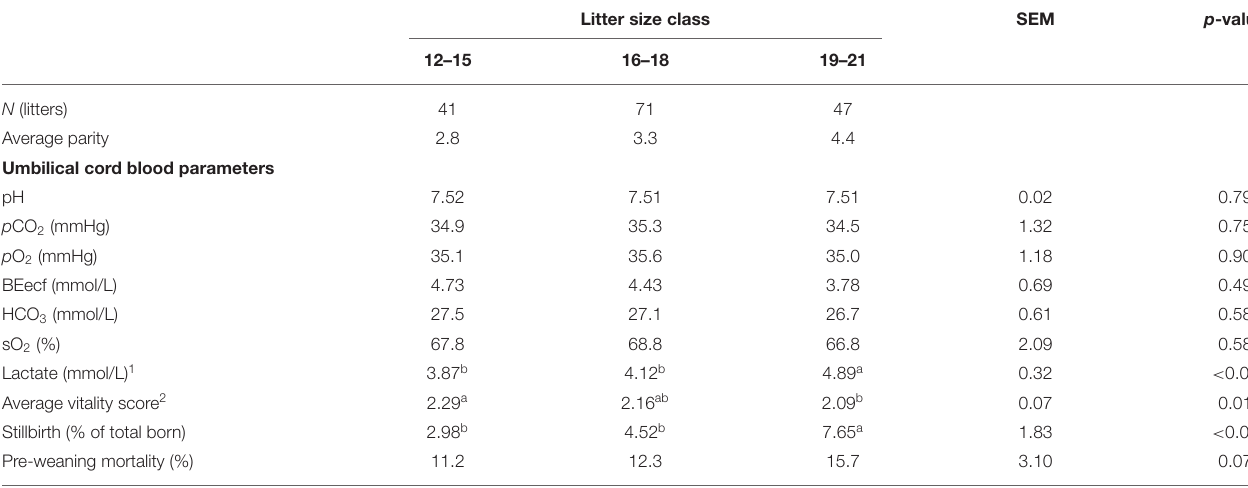
TABLE 1 | Effects of litter size class (total born) on umbilical cord blood parameters immediately after birth, vitality of piglets, incidence of stillbirth, and pre-weaning mortality (LSmeans ± SEM).